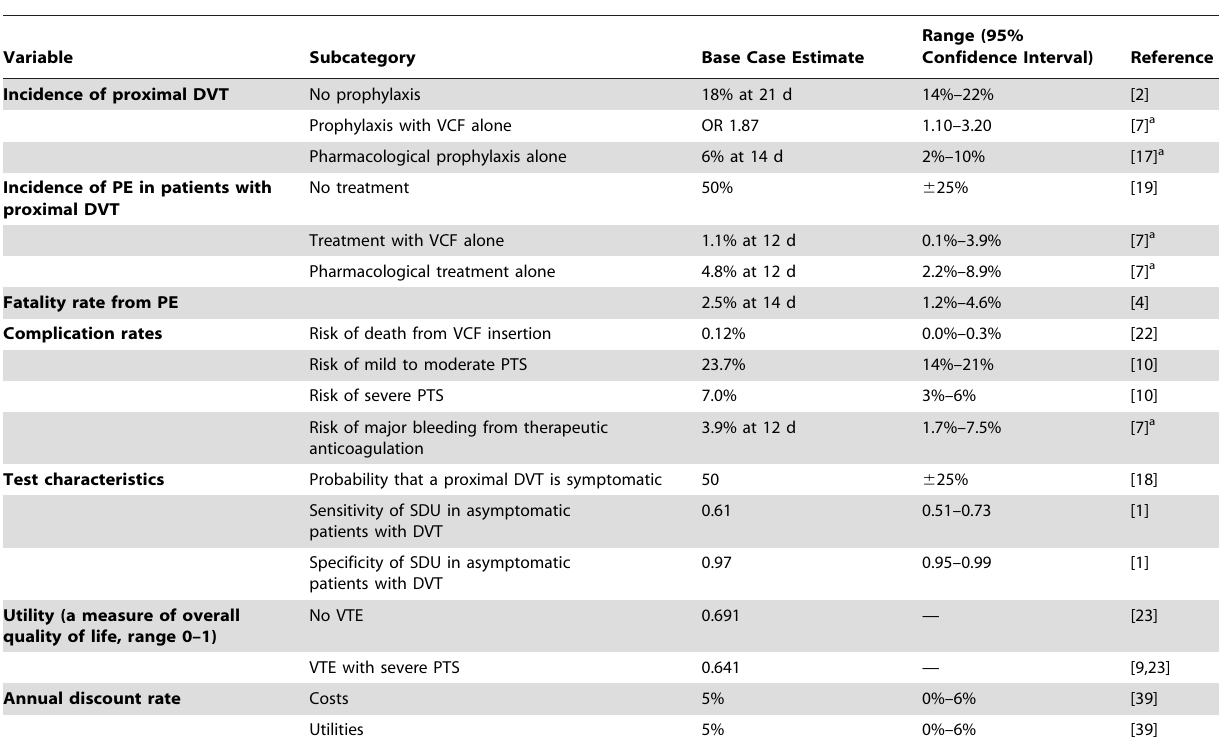
Table 2. Base case probabilities and ranges